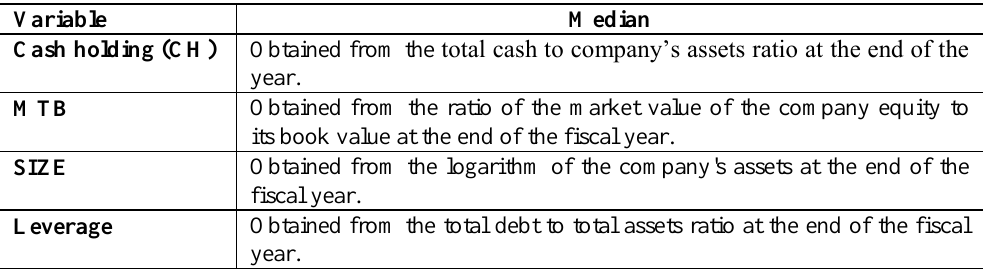
Table 1. Definitions of control